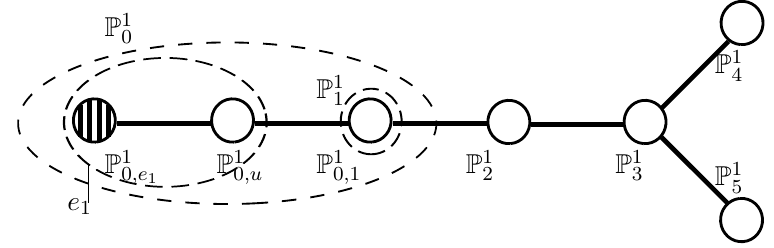
Figure 11 . P 1 intersection pattern at z 10 10 1 (cid:0) 3 = 2 (cid:0) 3 = 2 3